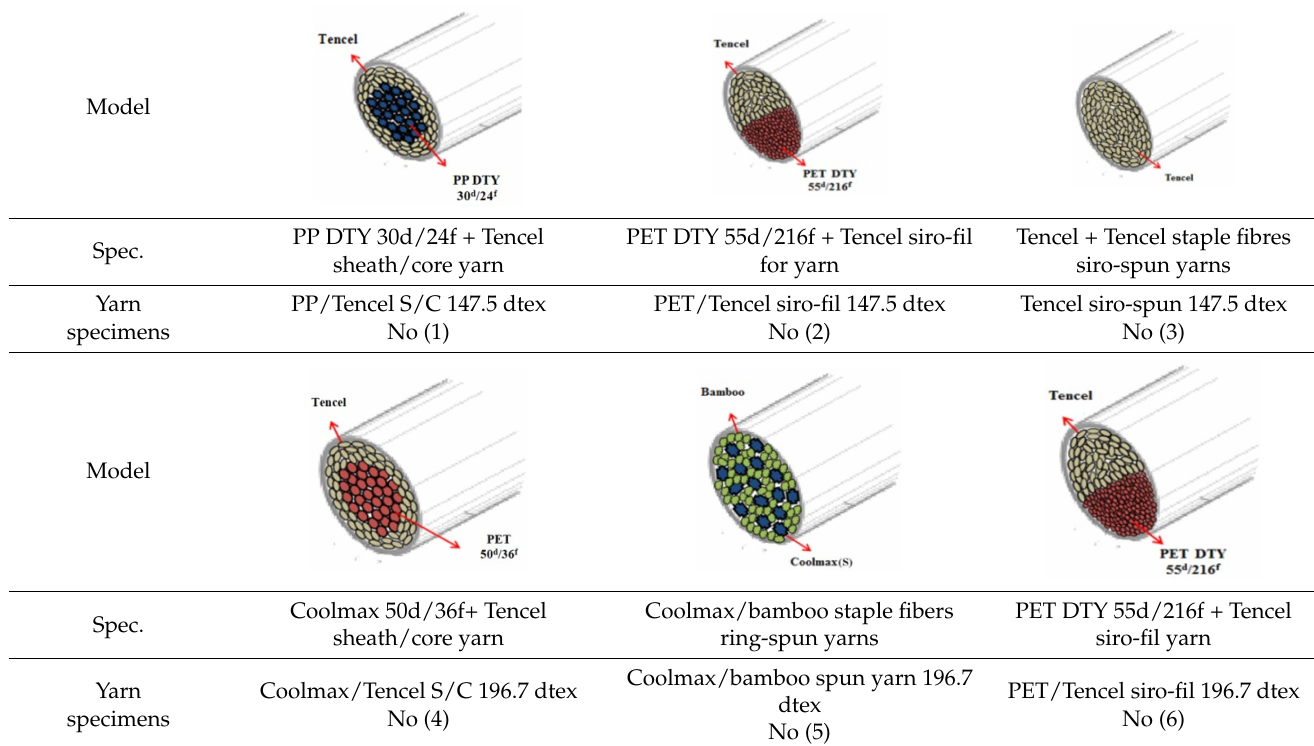
Table 2. Composite warp and weft yarn models